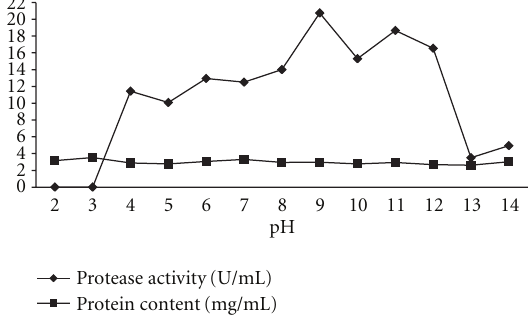
Figure 1: Stability of DLBS1033 in the range of pH. DLBS1033 was examined in pH range of 2–14.